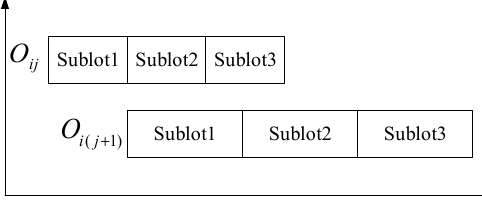
Figure 1. The overlapping in operations.